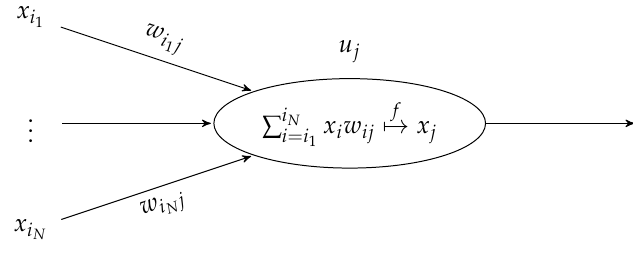
Figure 2. Scheme of a typical Neural Network (NN) unit